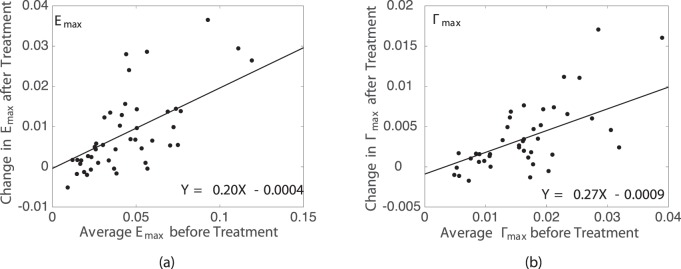
Correlation between the regionally averaged strain magnitudes at 45 mm Hg before treatment and the decrease in strain magnitude after treatment for (a) Emax and (b) Γmax.